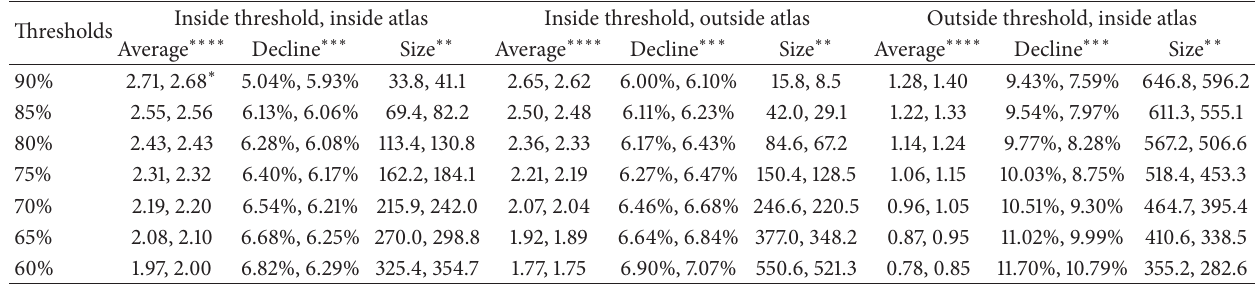
Table 4: Striatal DAT availabilities, declines per decade of DAT availabilities, and striatum sizes in the regions: (1) inside both the threshold ROIs and the atlas-defined ROIs, (2) inside the threshold ROIs but outside the atlas-defined ROIs, and (3) outside the threshold ROIs but inside the atlas-defined